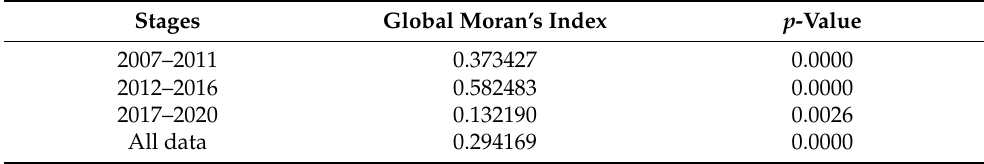
Table 2. Global Moran’s I for residential land price.